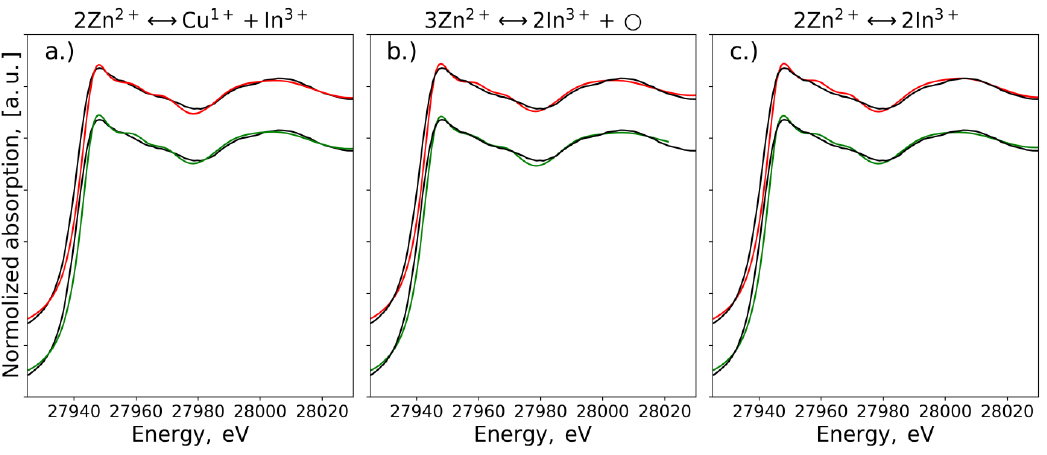
Figure 5. Comparison of experimental (Sample 3757) and calculated In K -edge XANES spectra. The calculation was performed for different models of In-bearing sphalerite obtained by DFT: ( a ) 2Zn 2+ ↔ Cu 1+ + In 3+ substitution; ( b ) 2Zn 2+ ↔ In 3+ + □ substitution; ( c ) 2Zn 2+ ↔2 In 3+ substitution. Black lines are used to plot the experimental spectra of Sample 3757; red lines—calculated spectra for structures with impurities and / or vacancy placed far from each other; green lines—calculated spectra for the structures with impurities and vacancy placed in the nearest positions.